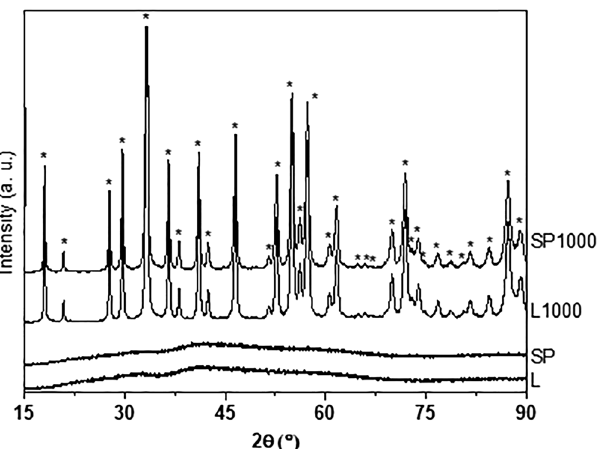
Figure 3. Dried (L, SP) and calcined (L1000, SP1000) YAG xerogel XRD patterns. (*) Peaks corresponding to the ICSD reference card for Y 3 Al 5 O 12 , PDF